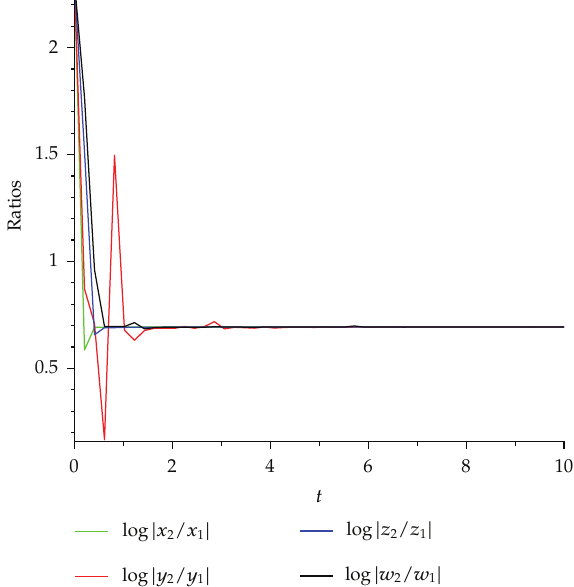
Figure 4: It shows the evaluation of the ratios log | x 2 /x 1 | , log | y 2 /y 1 | , log | z 2 /z 1 | , and log | w 2 /w 1 | whose limits are equal to log2 (cid:8) 0 .